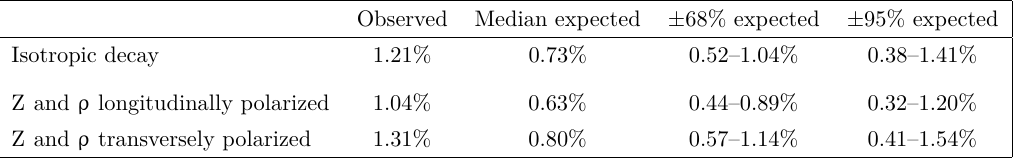
Table 3 . Observed and expected 95% CL upper limits on B (H → Z (cid:26) ) , for different polarizations.